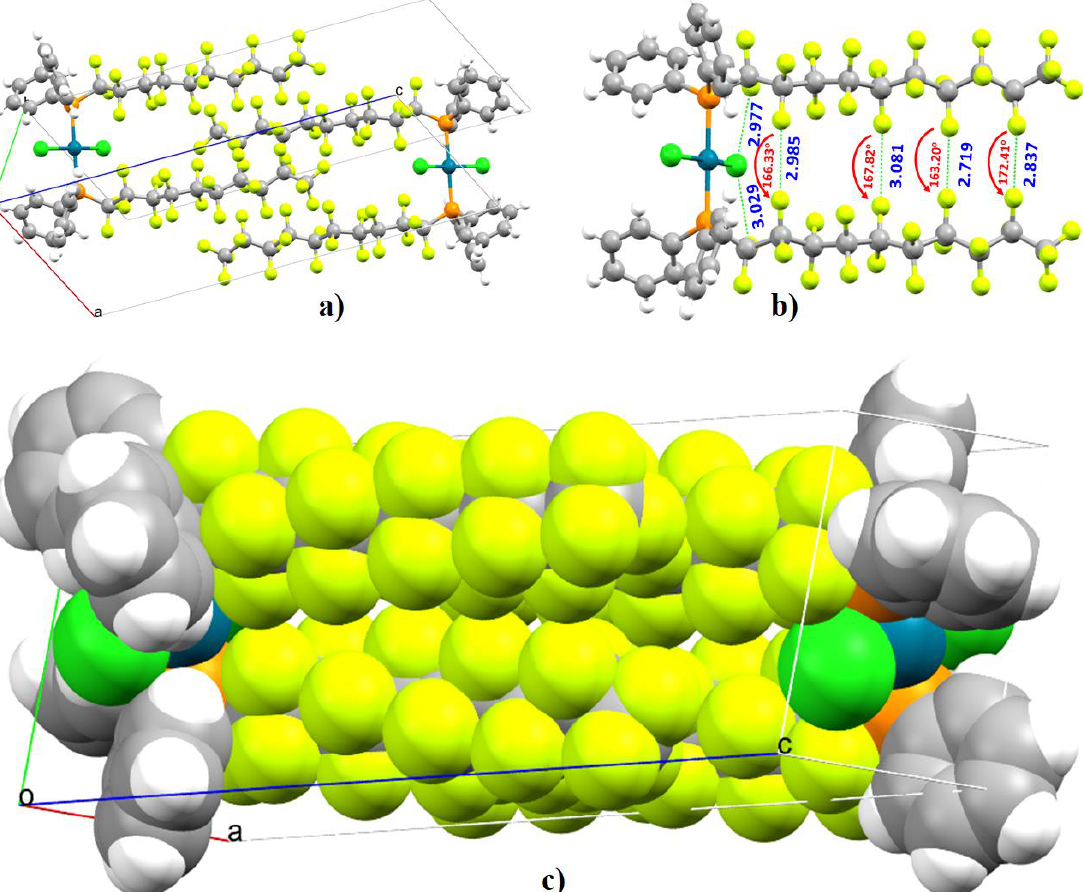
Figure 25. ( a ) The unit cell of the dichloro-bis((henicosafluorodecyl)(diphenyl)-phosphine)-palladium(II) crystal (CSD ref: ZETSIC). ( b ) Selected intramolecular contacts within the framework of the monomer. Intermolecular distances and angles are in Å and degrees, respectively. ( c ) The space-filling model of the unit cell of the crystal, showing potential overlap between the vdW spheres associated with the F atoms.